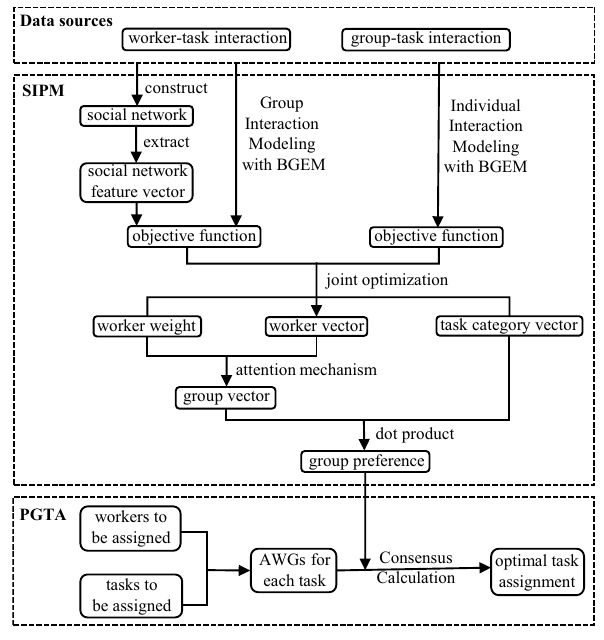
Fig. 2 Framework of our